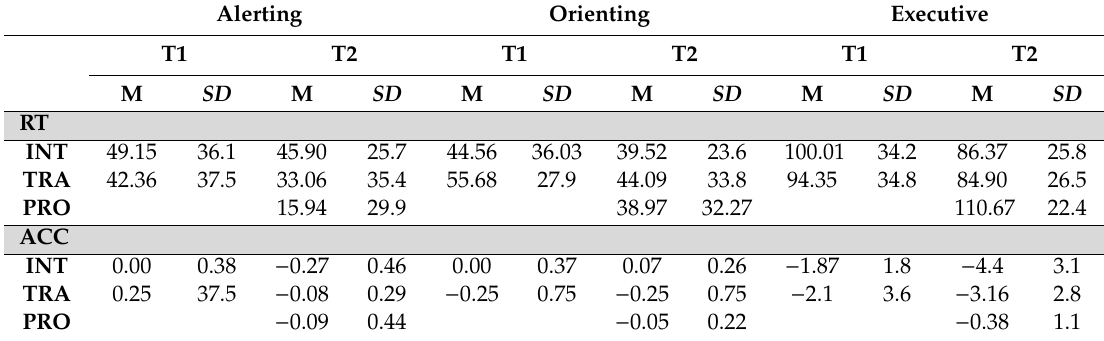
Table 3. Three ANT e ff ects: Response times and accuracy scores (means, SDs) for three groups.